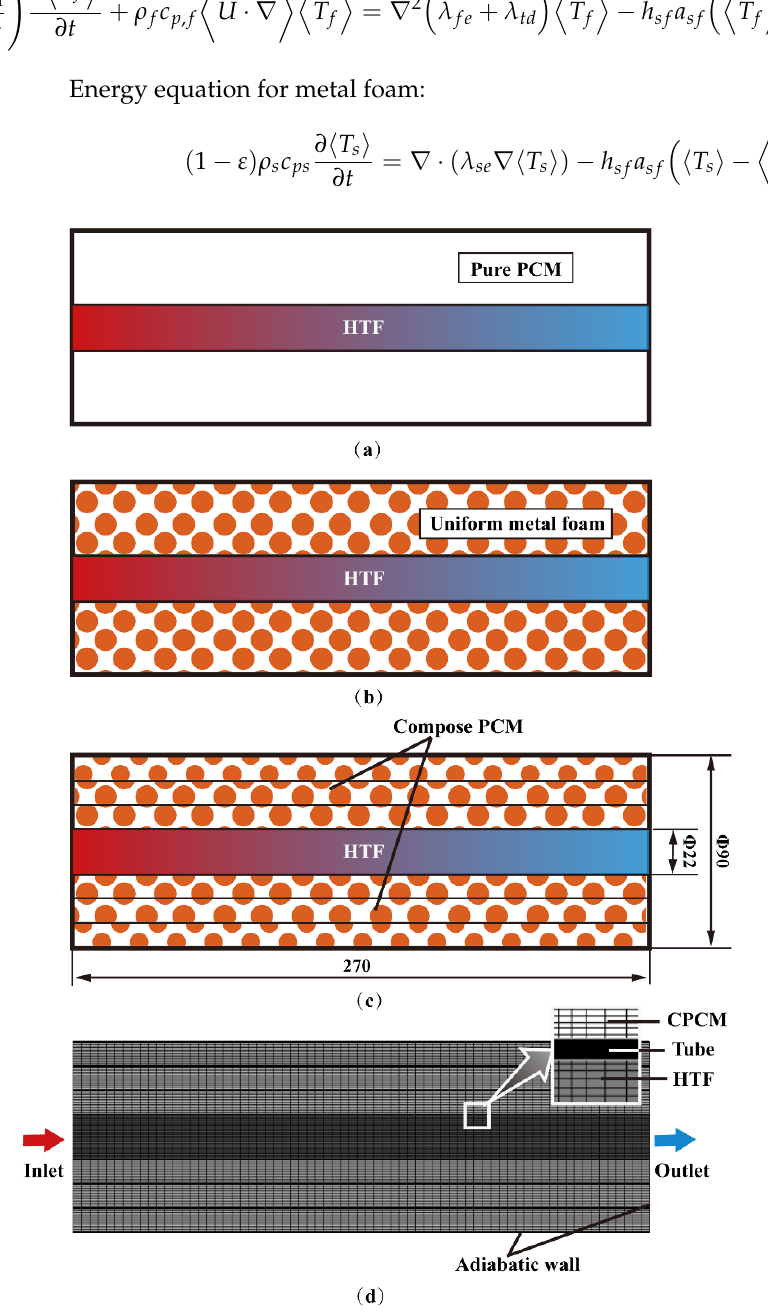
Figure 2. Horizontal TES tube with graded metal foam: ( a ) pure PCM structure; ( b ) uniform metal foam structure; ( c ) gradient foam structure; and ( d ) representative grid.